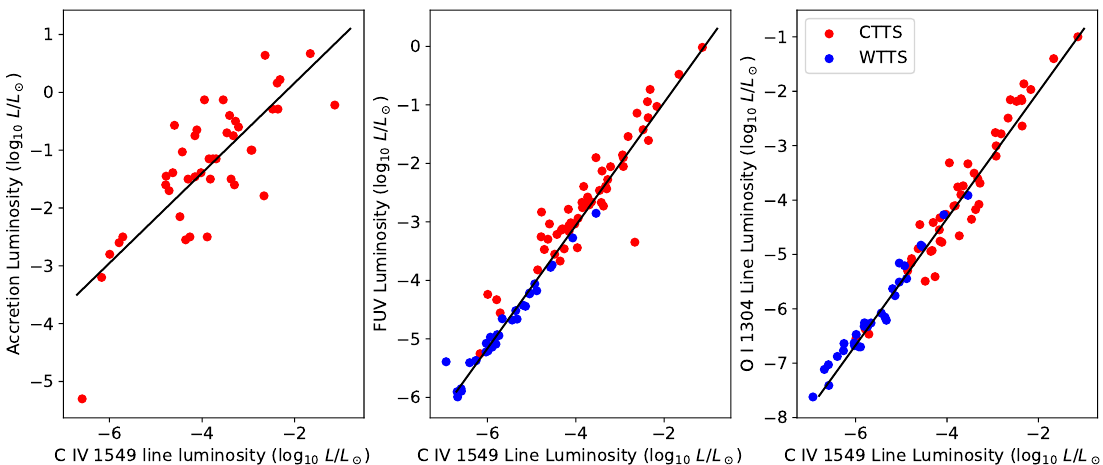
Figure 4. Left : Correlation between extinction-corrected C IV and accretion luminosity. This suggests that the C IV in CTTSs is mostly due to the accretion process. Middle : Correlation between C IV and total UV luminosity. Right : Relation between line fluxes. Data and fits from Yang et al.